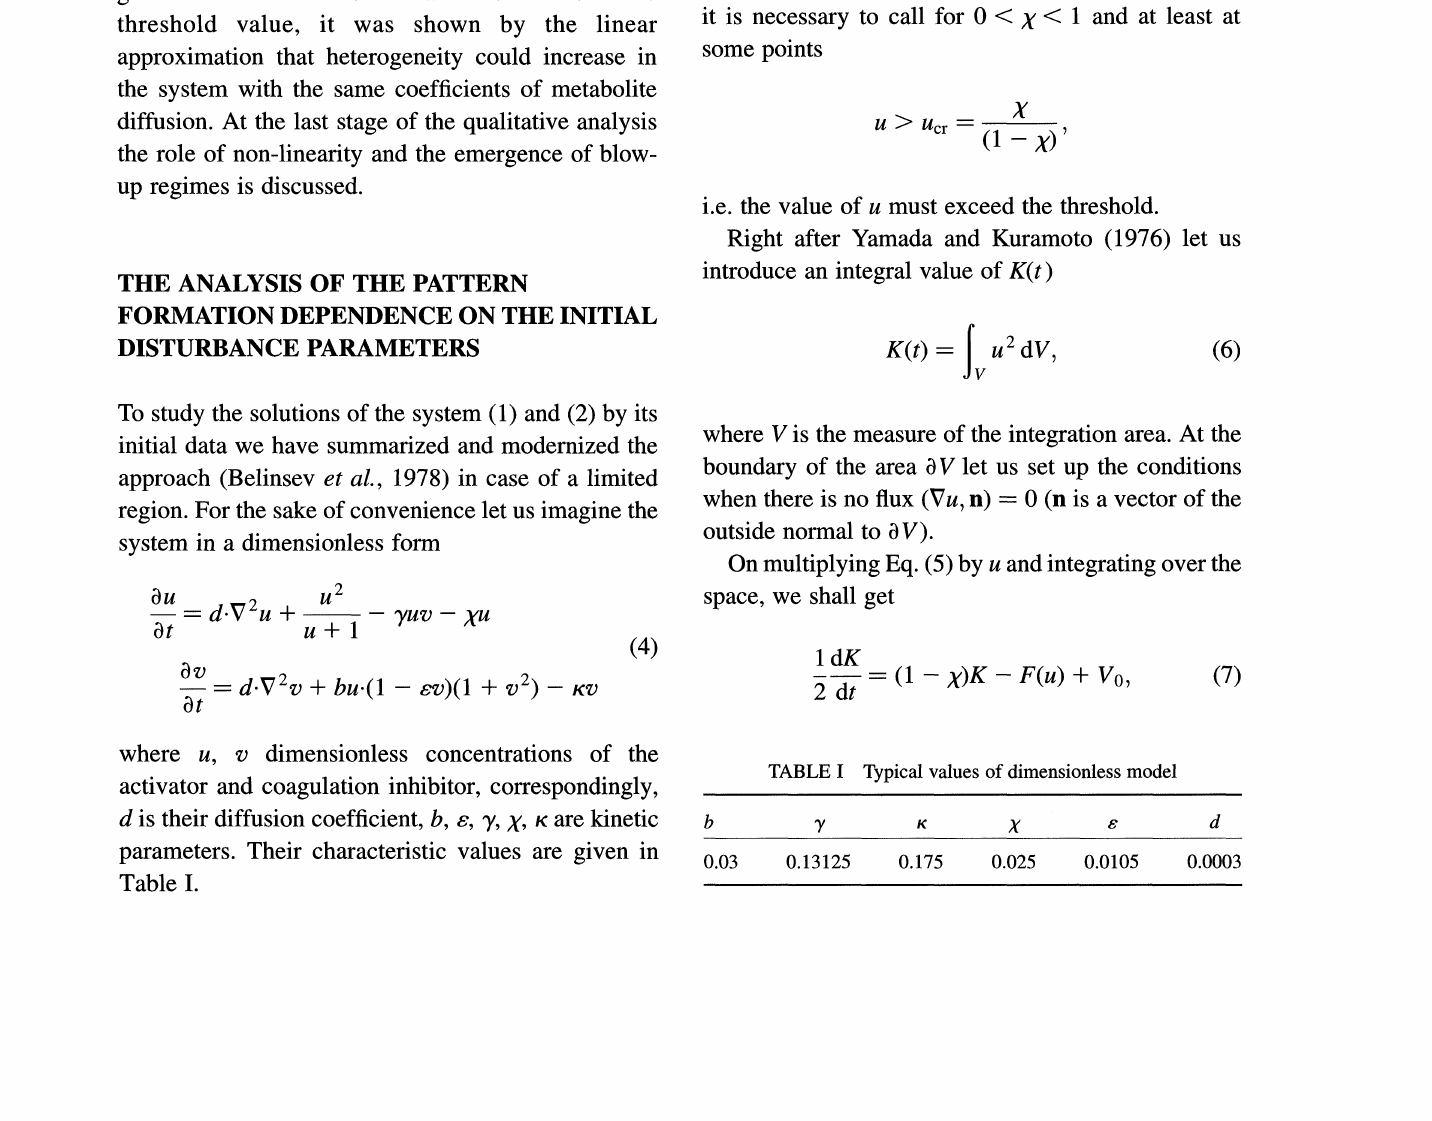
FIGURE 3 Dependence of solutions of the system (1)-(3) on the parameters of initial disturbance in one-dimensional-plane case. The values of other parameters are the same as in Fig. 1, besides q0 0.05252 nM. Designations are the same as in the Fig. 2 [1] mm, [J] nM mm.